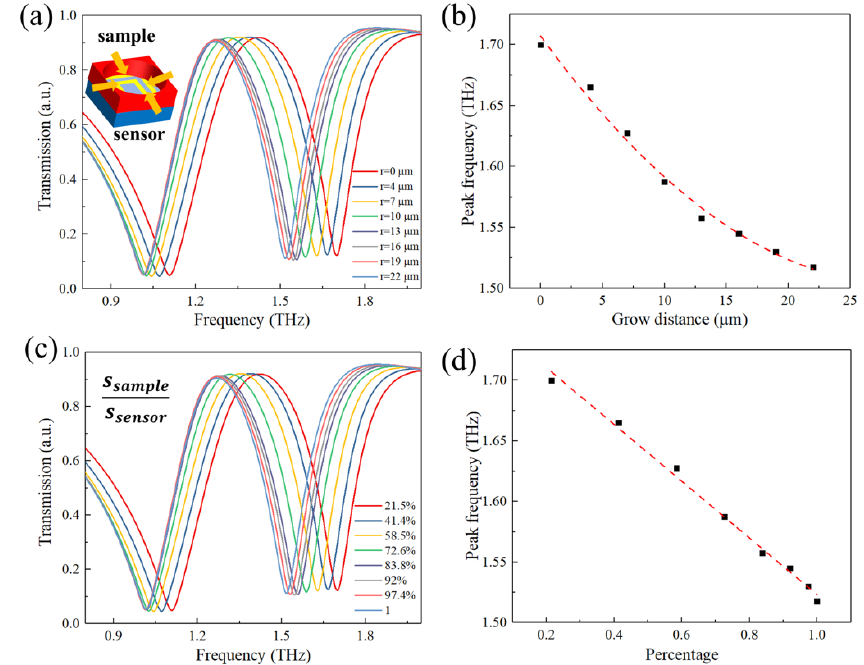
Figure 4. The cell growth simulations of the metamaterial biosensor. ( a ) The simulated transmission spectra of metamaterial under different cell growth distances. The inner graph shows the schematic illustration of simulation; ( b ) the dependence of peak 1 shift extracted from ( a ) on growth distance. ( c ) The simulated transmission spectra of metamaterial under different cell area ratios. ( d ) The dependence of peak 1 shift extracted from ( c ) on the growth distance area ratio of the cell.